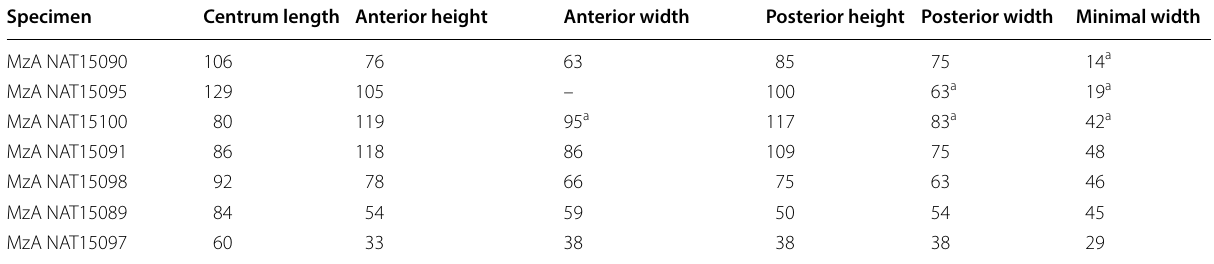
Measurements are in mm a Indicates deformation